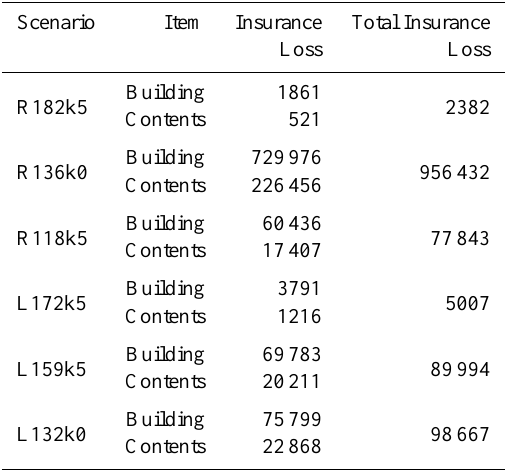
Table 2. Estimated insurance loss for residential buildings and con- tents (unit: million JPY).